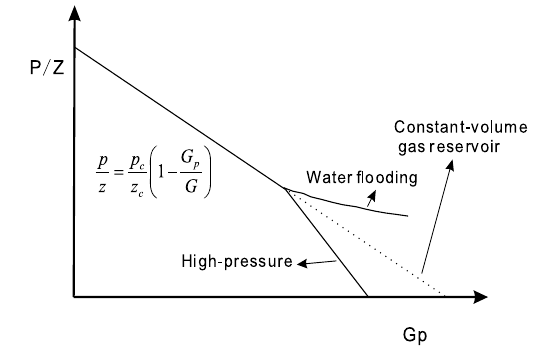
Fig. 7 Pressure depletion curve of